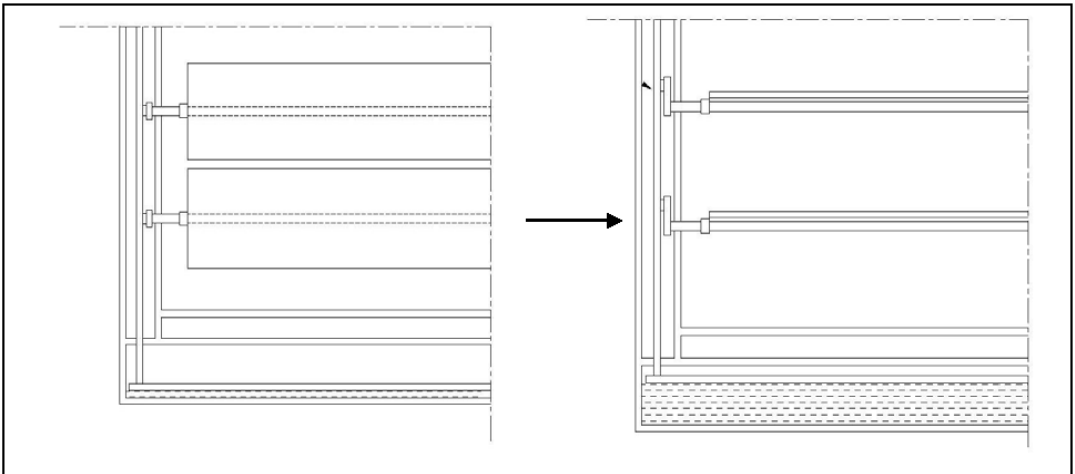
Figure 7. The moving status of floating